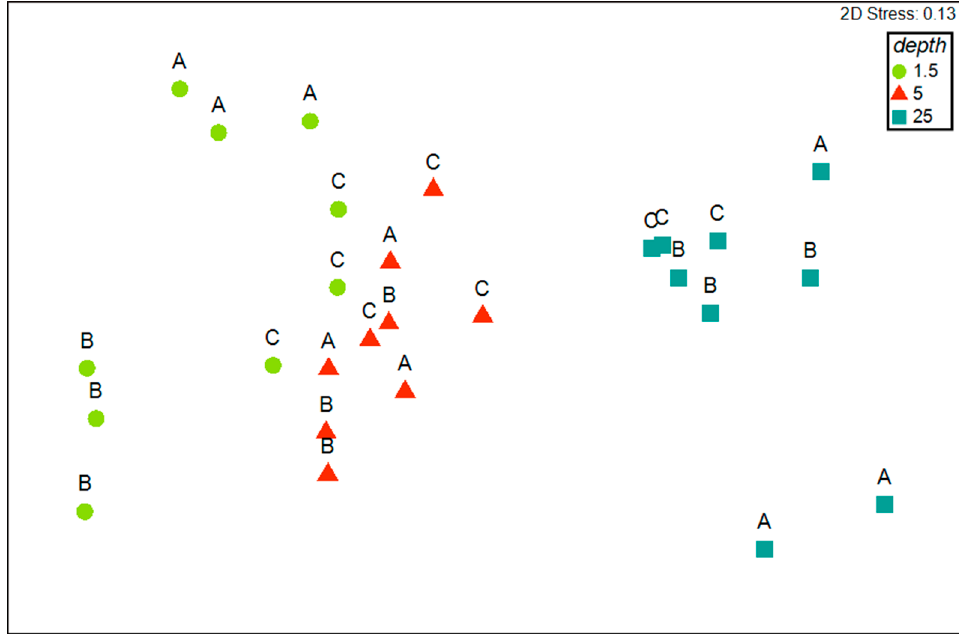
Figure 6. Nonmetric multidimensional scaling (MDS) ordination plot based on Bray–Curtis similarity of untransformed data, comparing structure of polychaete assemblages between samples. A – C = stations. The species that contributed with 4% or more to the dissimilarity between stations at each depth, were mostly the same ones that characterised that depth (Table S4): N. usticensis , N. pulsatoria , S. rosea Table 2. Results of SIMPER analyses (cut-off 70%) used to identify taxa that mostly contribute to ( A ) faunal similarity within depths, ( B ) faunal dissimilarity between depths. Abund = mean abundance, Sim% = mean similarity, Sim/SD = similarity/standard deviation, Contrib% = contribution relative to single taxon, Cum% = cumulative contribution, Av.Ab = mean abundance, Diss% = mean dissimilarity, Diss/SD = dissimilarity/standard deviation.